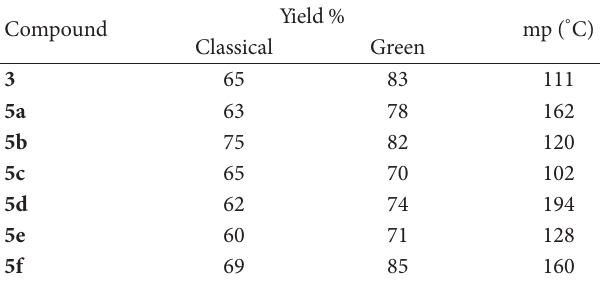
T 2: Yield and melting points of Stobbe products 3 , 5a–f . Compound Classical